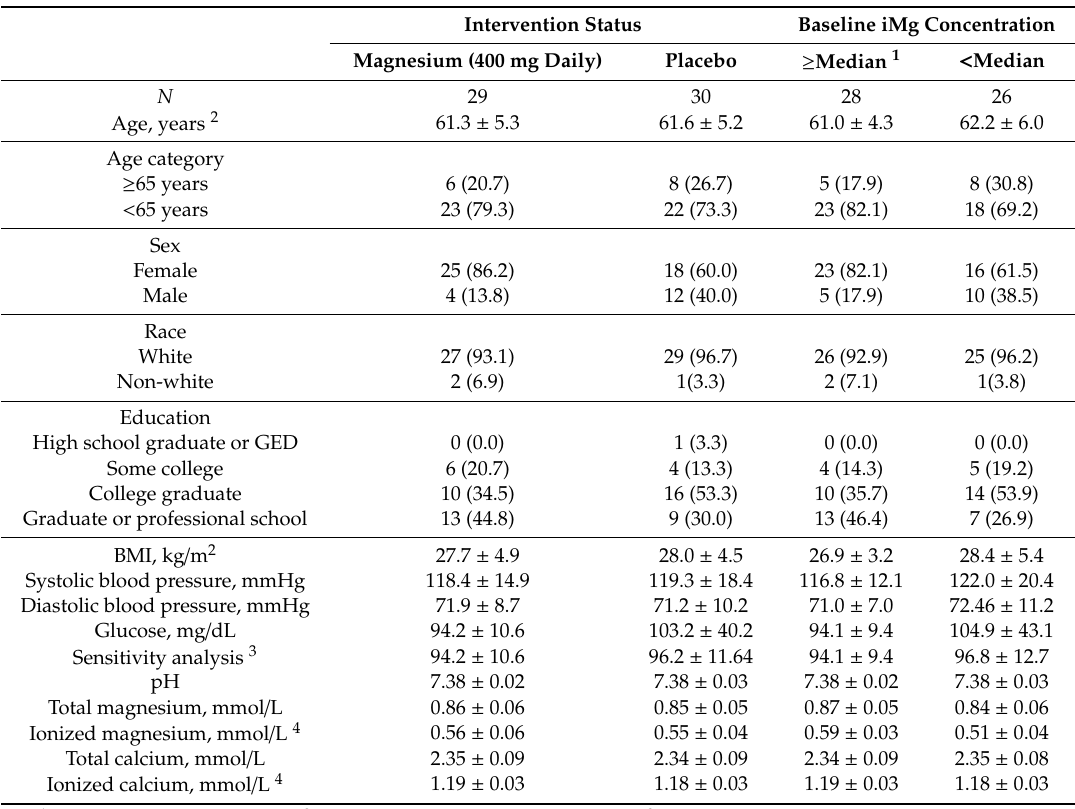
Table 1. Baseline participant characteristics stratified by study arm and by baseline ionized magnesium concentration (above vs. below the median), n =